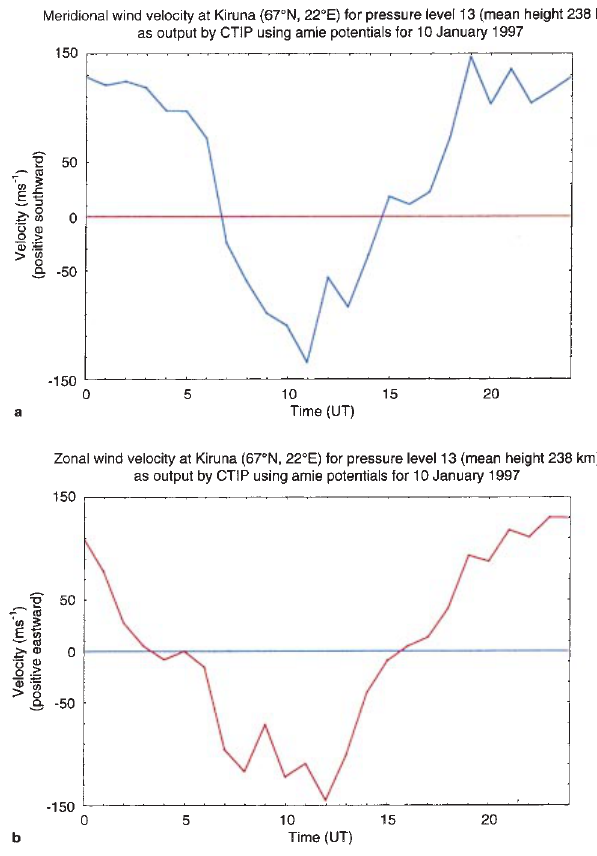
Fig. 9a, b. The variation of the meridional and zonal wind in the upper thermosphere during January 10 1997, simulated by the CTIP- 200 global